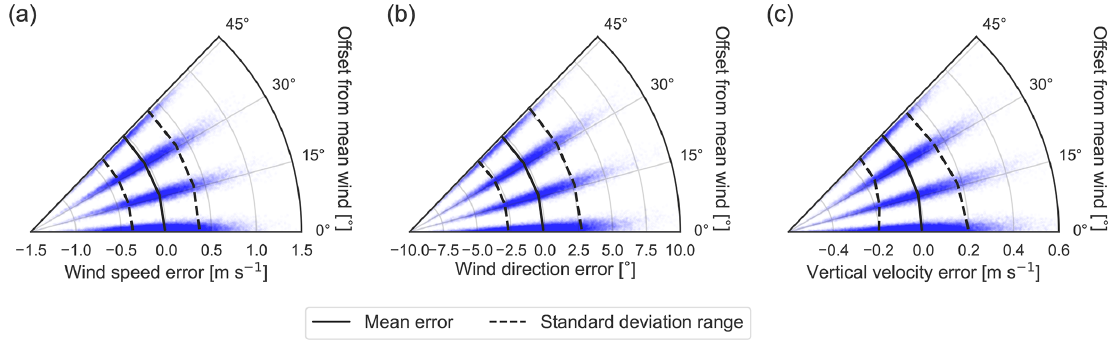
Figure 13. Errors in the 100m (a) wind speed, (b) wind direction, and (c) vertical velocity (wind direction weighting, Eq. 9) in the stable BL case plotted against the offset angle between the wind direction and the nearest lidar axis. Lines show the means (solid) and standard deviation interval